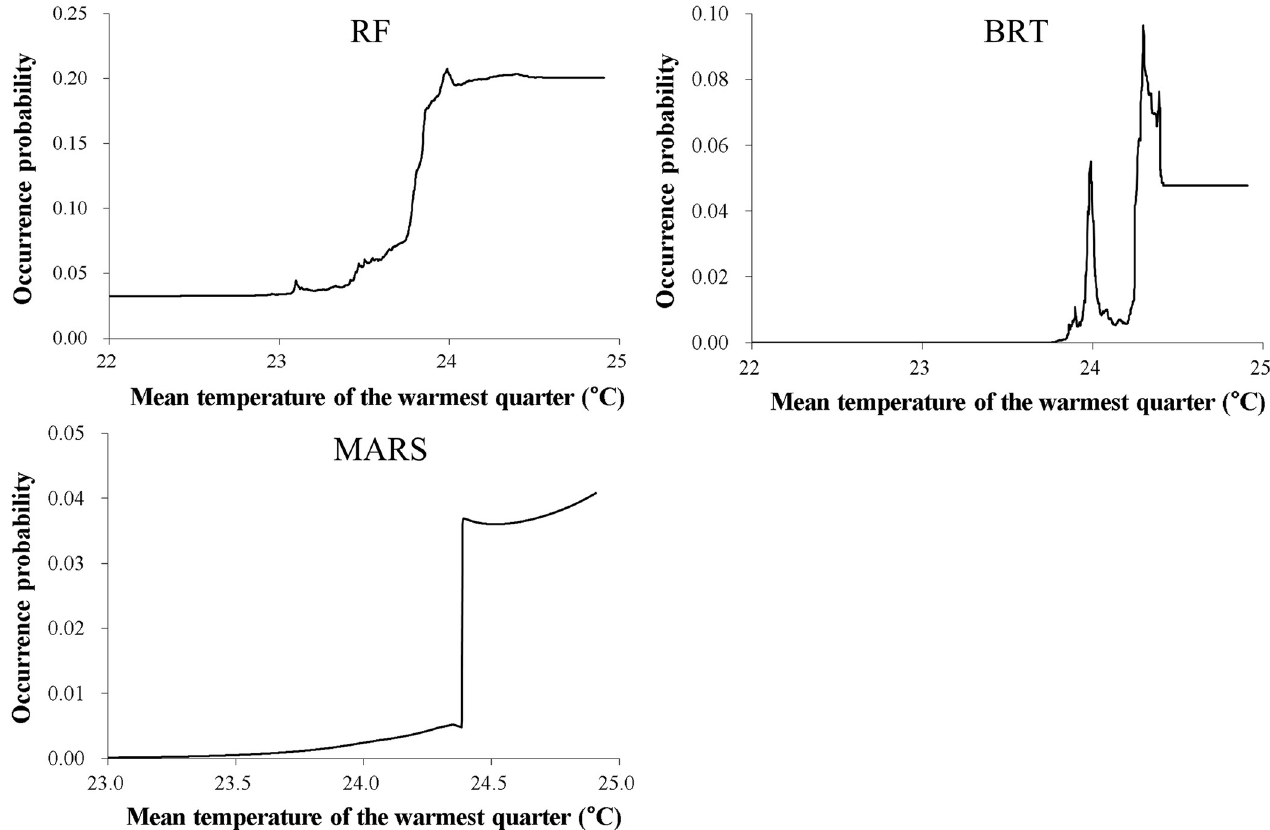
Fig 4. Response curves for the second important predictor, the mean temperature of the warmest quarter for three of the five species distribution models for nutrias (producing Δ AUC values � 0. 05). RF = Random Forest; BRT = Boosted Regression Trees; MARS = Multivariate Adaptive Regression Spline.